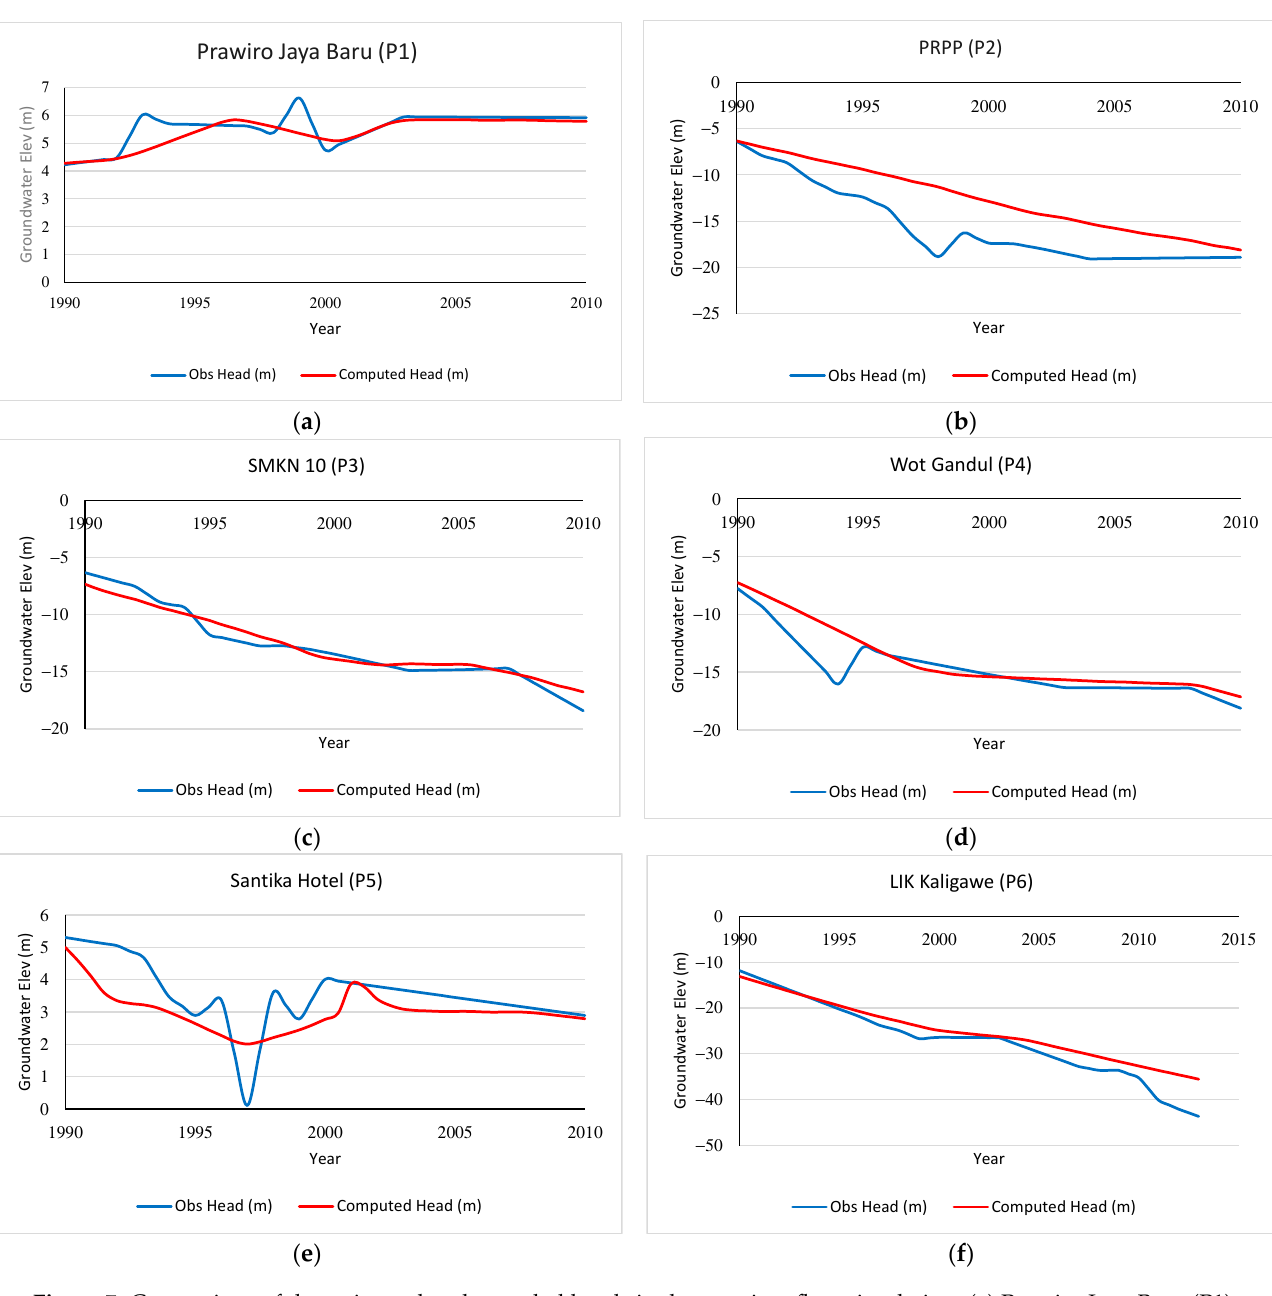
Figure 7. Comparison of the estimated and recorded heads in the transient flow simulation: ( a ) Prawiro Jaya Baru (P1); ( b ) PRPP (P2); ( c ) SMKN 10 (P3); ( d ) Wot Gandul (P4); ( e ) Santika Hotel (P5); ( f ) LIK Kaligawe (P6).